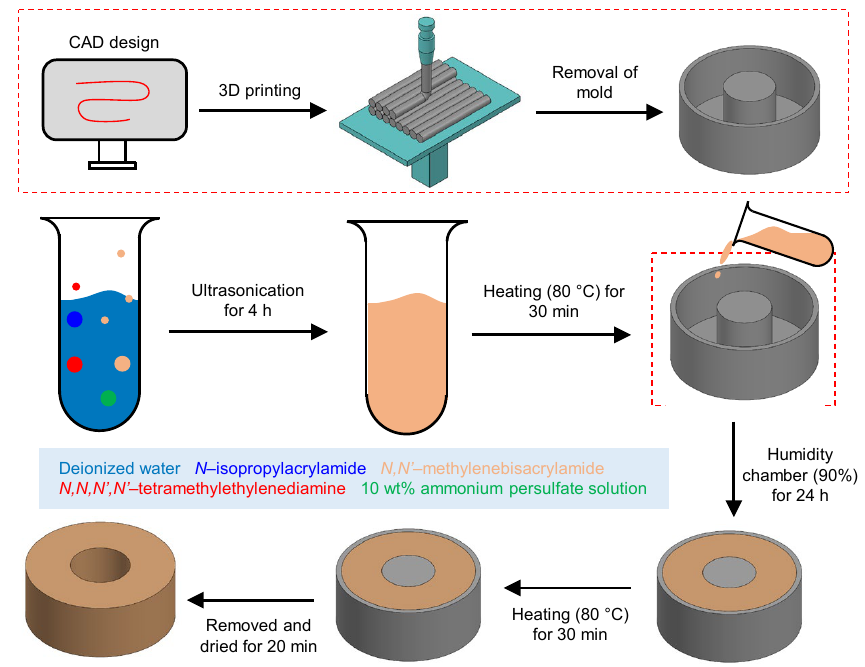
Figure 1. Steps involved in the fabrication of